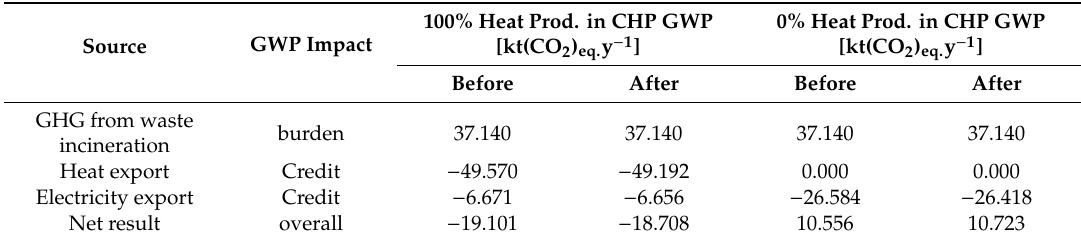
Table 1. Global warming potential (GWP) of residual waste (RES) in waste ‐ to ‐ energy (WtE) before and after biowaste component diversion .